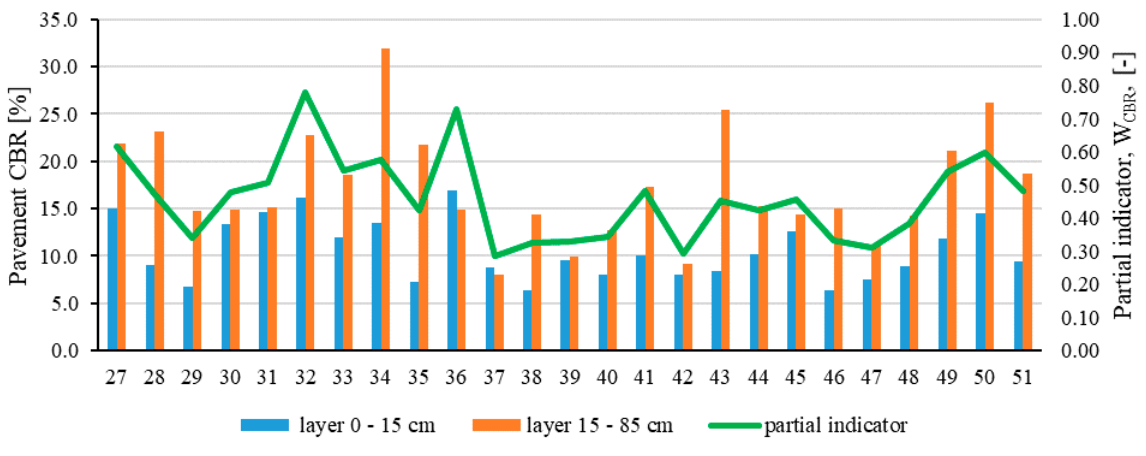
Figure 12. Results of the load bearing capacity of natural airfield pavements on the northern shoulder.